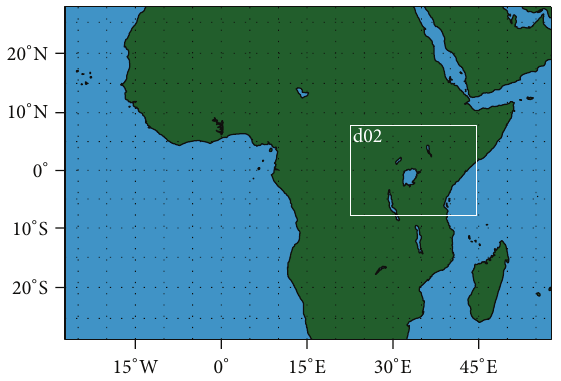
Figure 2: The domains used in WRF. The large domain, one, is at a grid spacing of 50km and the smaller, two, nested within one has a grid spacing of